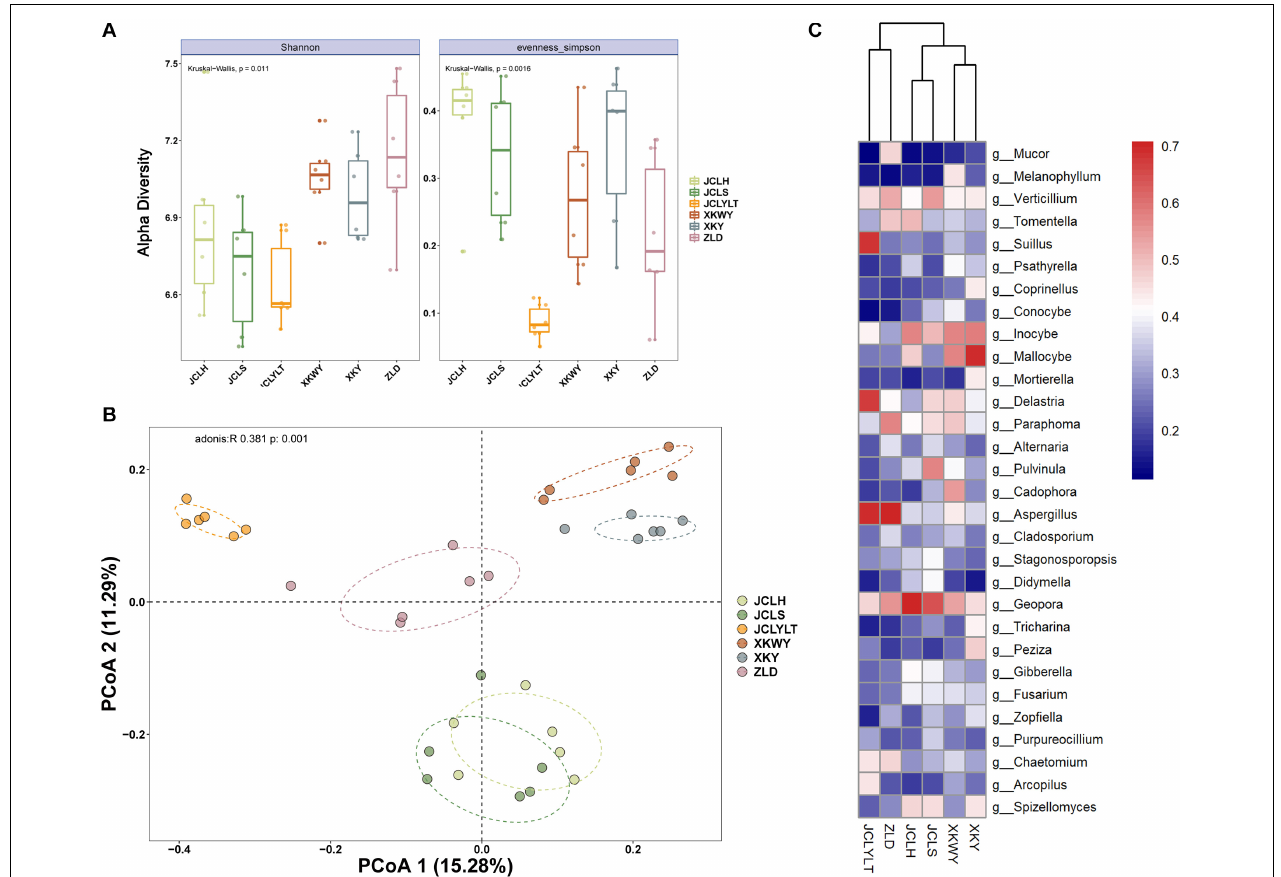
FIGURE 4 | (A) Alpha diversity analysis based on the OTUs account for the species richness using eveness Simpson index and species diversity using Shannon index. (B) The Bray–Curtis dissimilarity principal coordinate analysis (PCoA) of bacterial community structures in different soils. (C) Characteristic bacterial populations with significant community differences in different